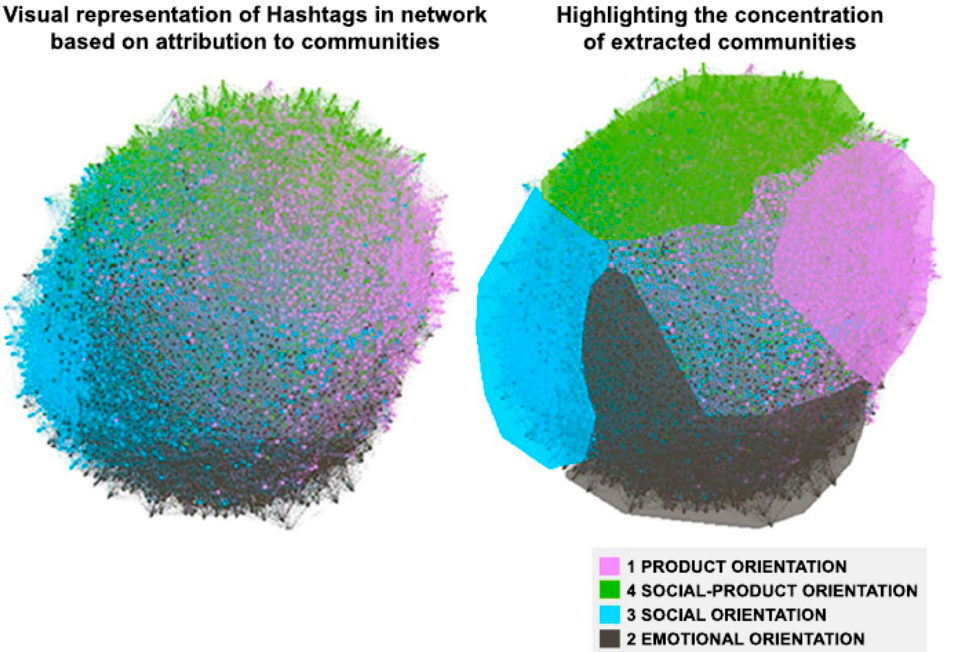
Figure 7. Example of tight communities. Source: “Customer Experience with Farmers’ Markets: What Hashtags Can Reveal” [12].